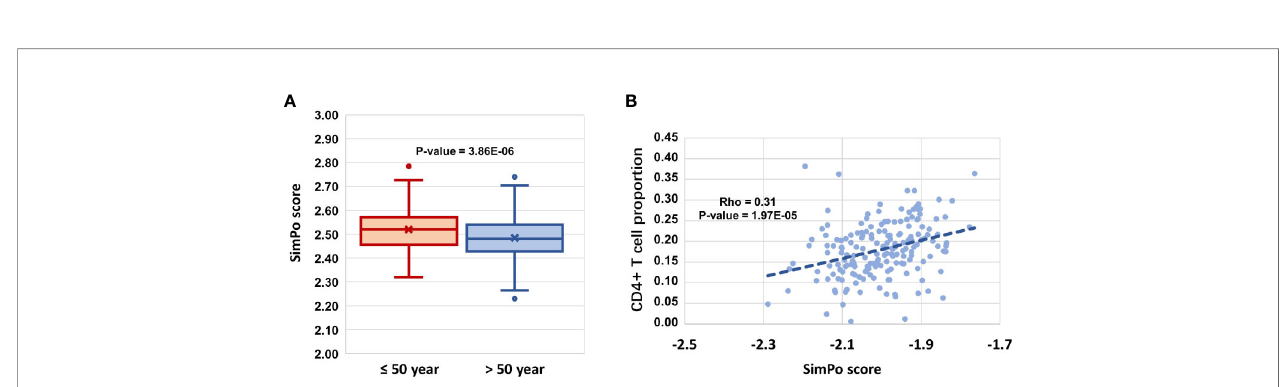
FIGURE 3 | (A) DZIP3 is signi fi cantly associated with aging. (B) DZIP3 is signi fi cantly associated with the CD4+ T cell